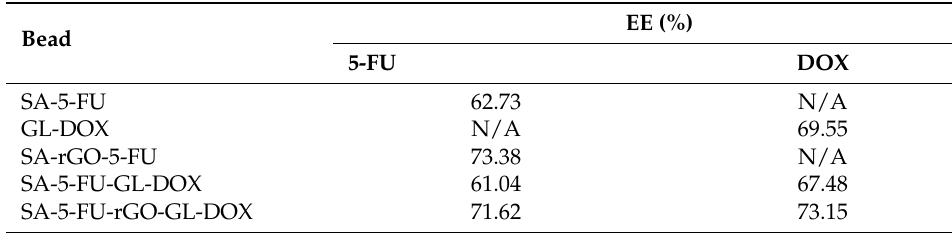
Table 1. The encapsulation efficiency (EE) of different beads.